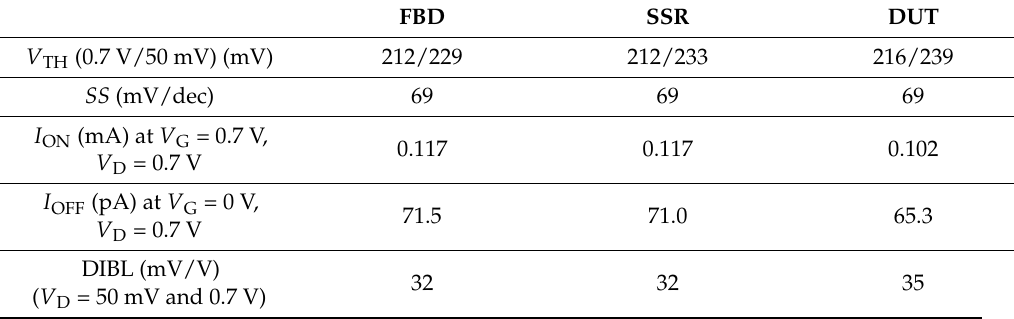
Figure 9. Various device structures without a GP region. NS FET with ( a ) full bottom dielectric (FBD) [25], ( b ) super steep-retrograde (SSR) region [14], and ( c ) the proposed DUT layer. ( d ) Simulated I D - V G characteristics of the respective device structures. Table 3. Comparison of NS FETs based on FBD, SSR, and DUT structures.